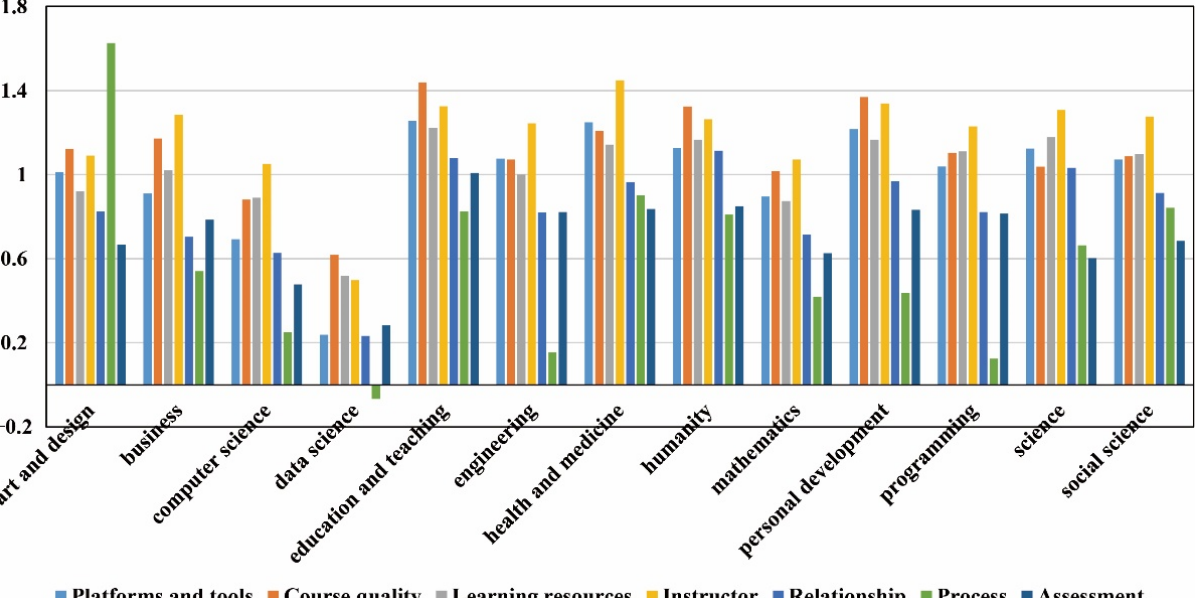
Figure 5. Averaged sentiment scores for each topic in different subjects (calculated based on “bing”).